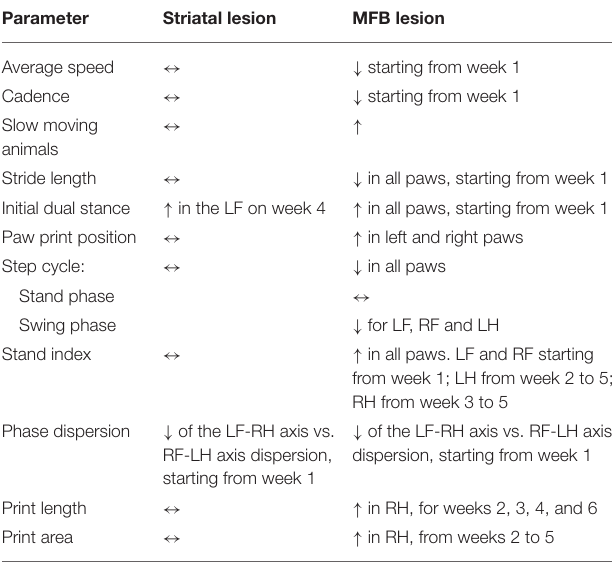
TABLE 1 | Summary of gait parameters